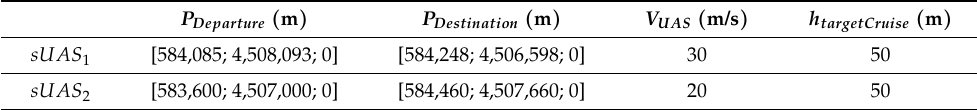
Figure 20. Flight altitude time histories for airspace volumization and flight corridor solutions for sUAS 2 in Figure 19 example. Table 9. Flight plan parameters for sUAS 1 and sUAS 2 .